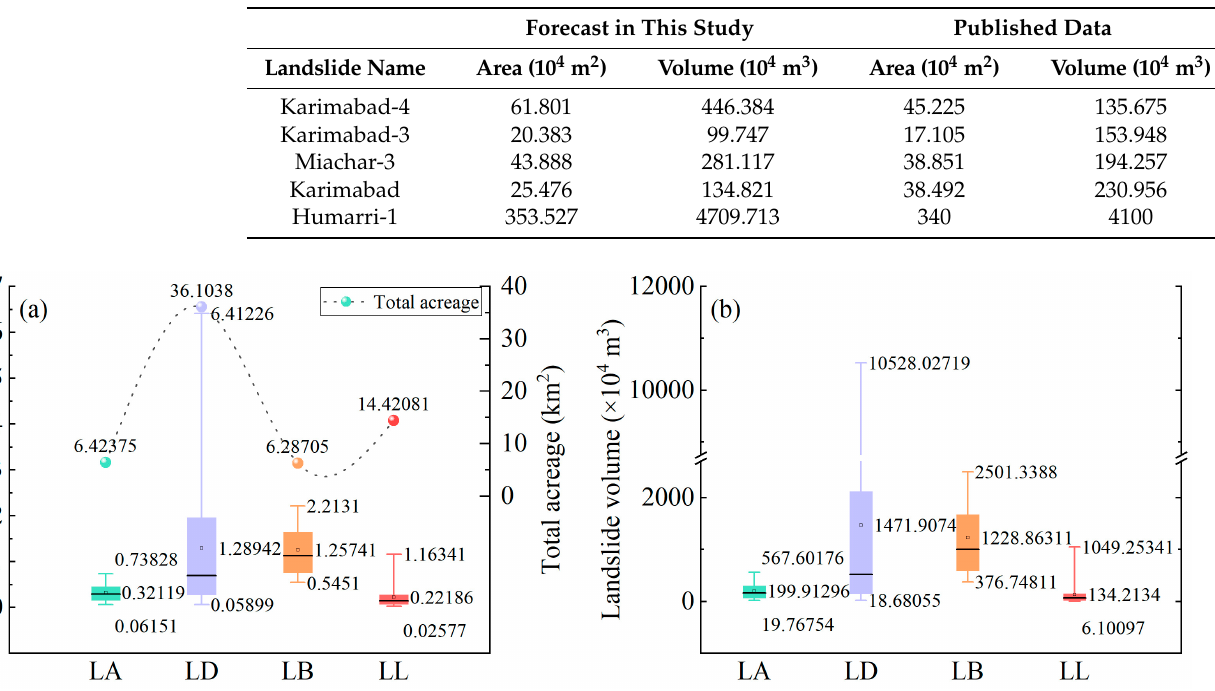
Table 2. Comparison of the landslide areas and predicted volumes in this study with published data [25,66]. Forecast in This Study Published Data